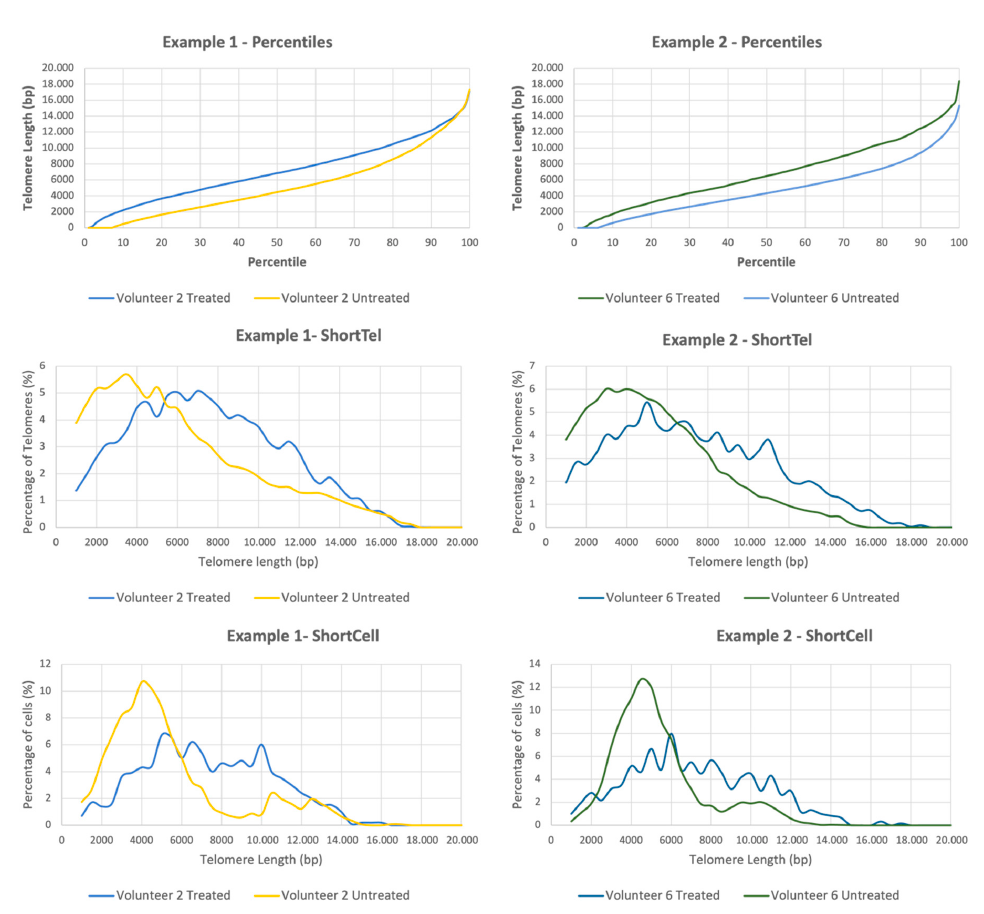
Figure 4. Two examples in comparison of control vs. treated according to telomere length and the three categories (Percentiles, ShortTel, and ShortCell).